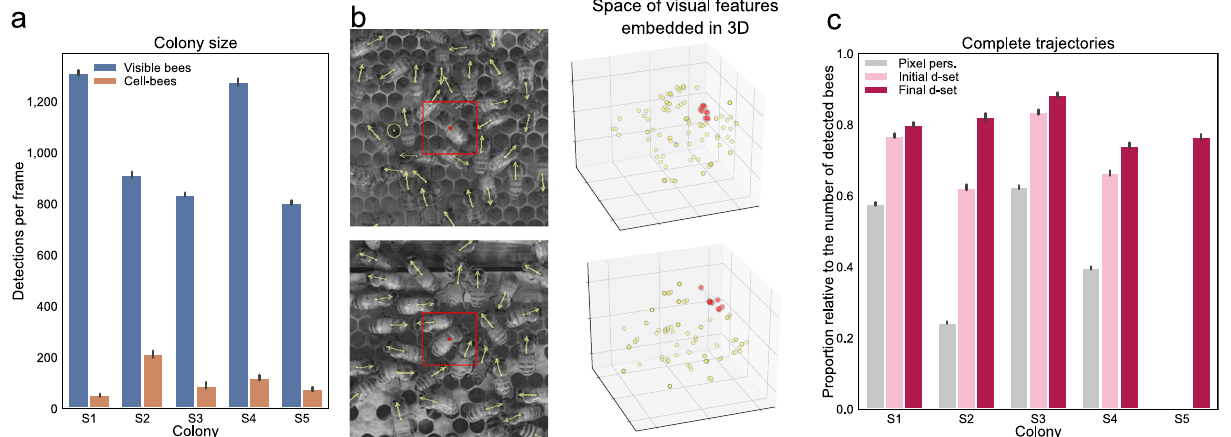
Fig. 4 Leveraging visual features for enhanced detection matching across frames. a Recordings from fi ve different beehives were used for tracking method development and testing. The hives contained varying total numbers of detected bees and of bees in comb cells (cell-bees). The colored bars show the mean number of detections across all frames (N = 3600), the error bars show their standard deviation. b CNN-derived vector embeddings are used to better match bee detections across video frames. Even though bees appear identical to a human observer, the embeddings belonging to one trajectory (red) are distant from embeddings of all other bee images neighboring in time and space, thus aiding the correct stitching of individual detections. The embeddings encode similarity among images of detections. Originally 64-dimensional, an example projection of the embeddings in 3D is shown in the panels on the right obtained with the use of t-SNE 98 . Red dots represent embeddings in 10 consecutive video frames of the bees marked by red squares in the left panels. Embeddings of other bee detections in these images that occurred over consecutive three video frames are marked by yellow dots in the panel on the right. c The accuracy of the tracking method obtained for test recording S5 matched the accuracy reached in recordings S1 – S4 used for network training and method design. We show the proportion of extracted trajectories relative to the average detected number of bees in hives S1 – S5. The proportion of extracted trajectories is shown for an earlier approach ( ‘ pixel personality ’ , gray bars), the current method but trained only the initial dataset (pink bars) and for the current method but trained on the fi nal dataset (red bars). The colored bars show the proportion relative to the mean number of detections in all frames, the error bars denote the standard deviation in proportions relative to the detection number across all frames ( N = 3,600). Source data are provided as a Source Data fi